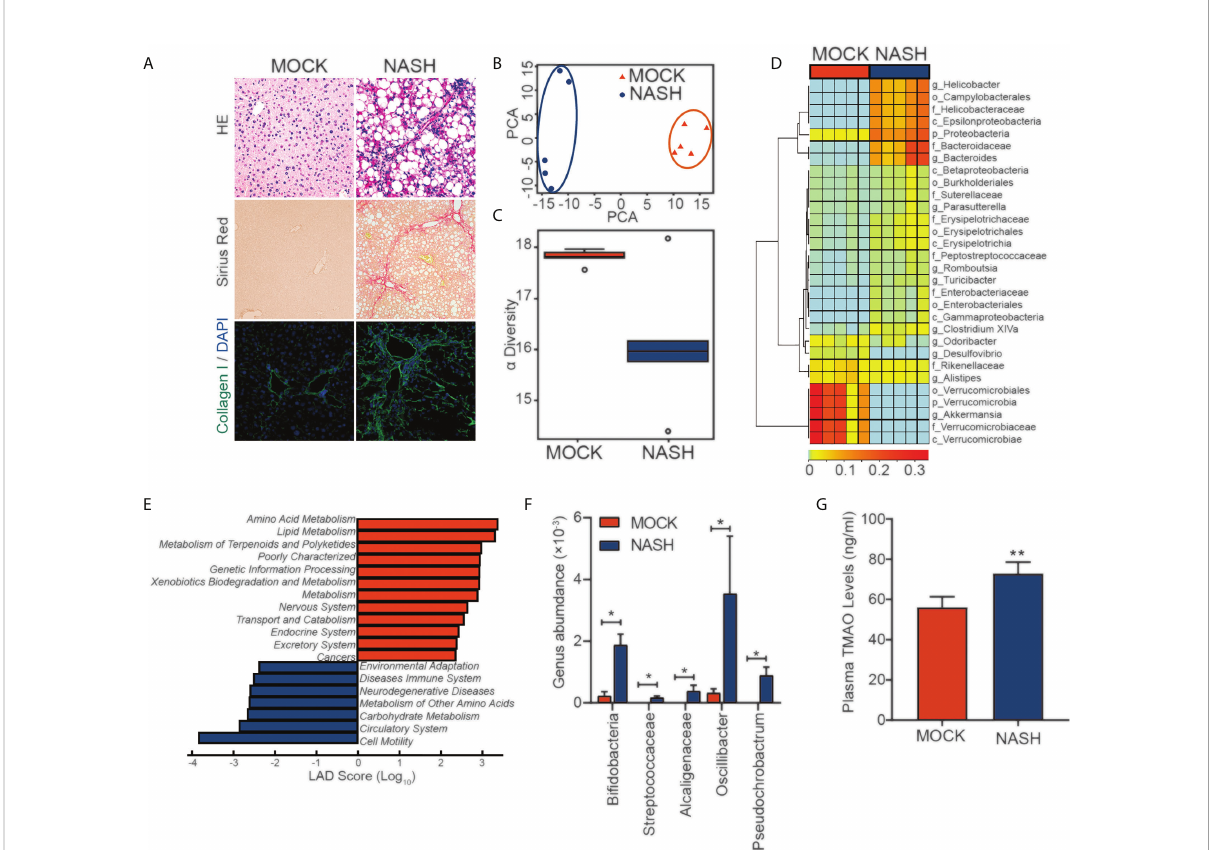
FIGURE 1 16S rDNA amplicon sequencing analysis of feces from a mouse NASH model (A) NASH was induced in the wild-type mice with a HFD diet and (0.8 g/kg)